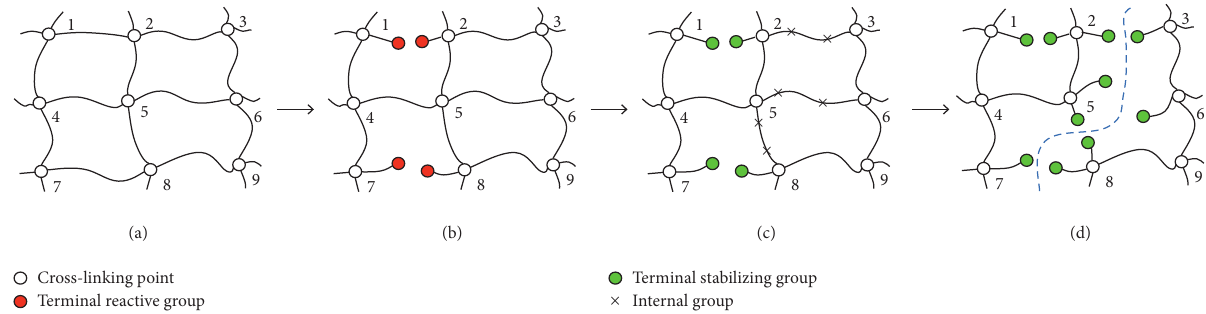
Figure 9: Mechanochemical model for decrosslinking of the thermosetting phenolic